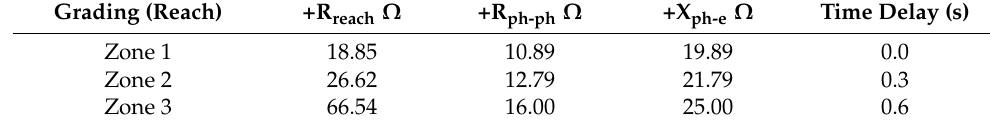
Table 2. Distance relay protection setting parameters.